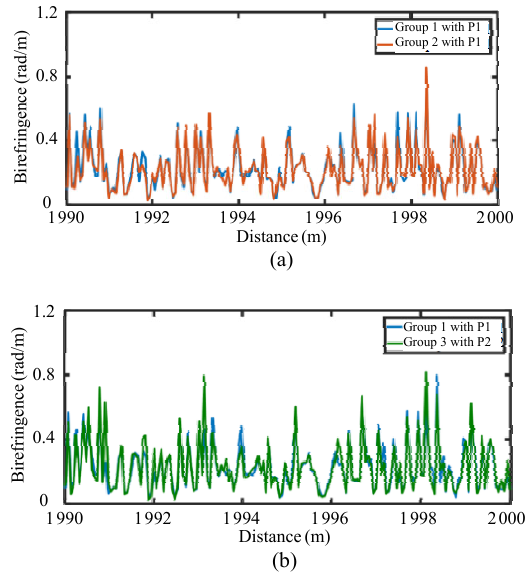
Fig. 15 Measurement birefringence results through coherent detection Φ -OTDR [42].